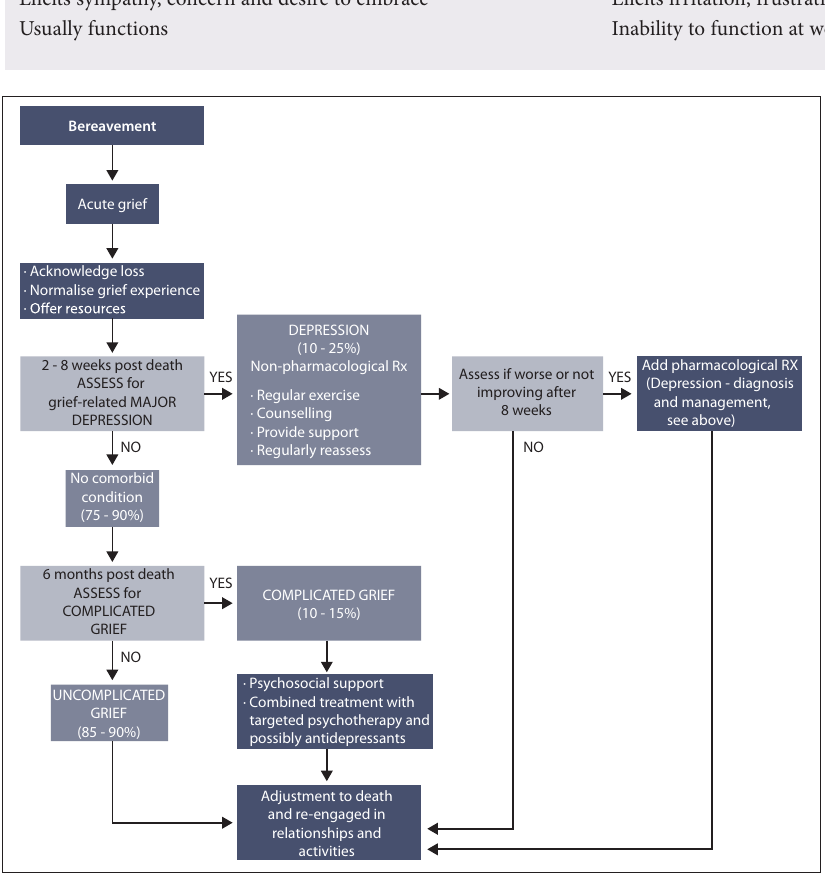
Fig. 6. Management of grief and bereavement.